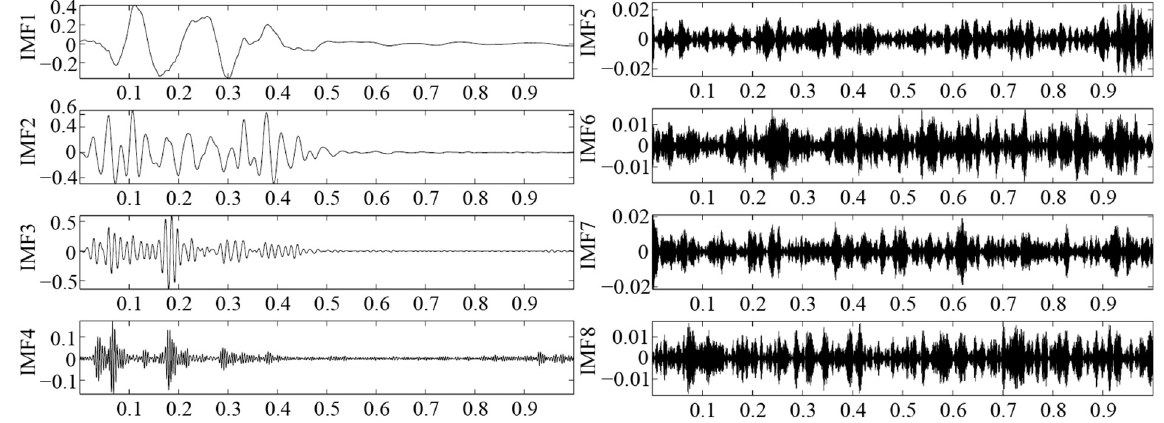
Figure 3. Decomposition results of the blasting vibration signal. Table 1. Mean MPE of IMF.